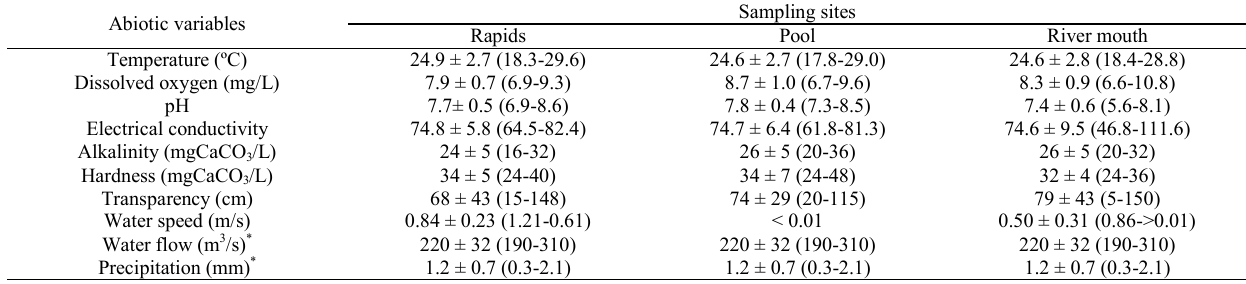
Table 2. Average values ± standard error and minimum-maximum values (in parenthesis) of the observed abiotic variables in the different sampling sites during the study period. *Average value observed among the sampling site.